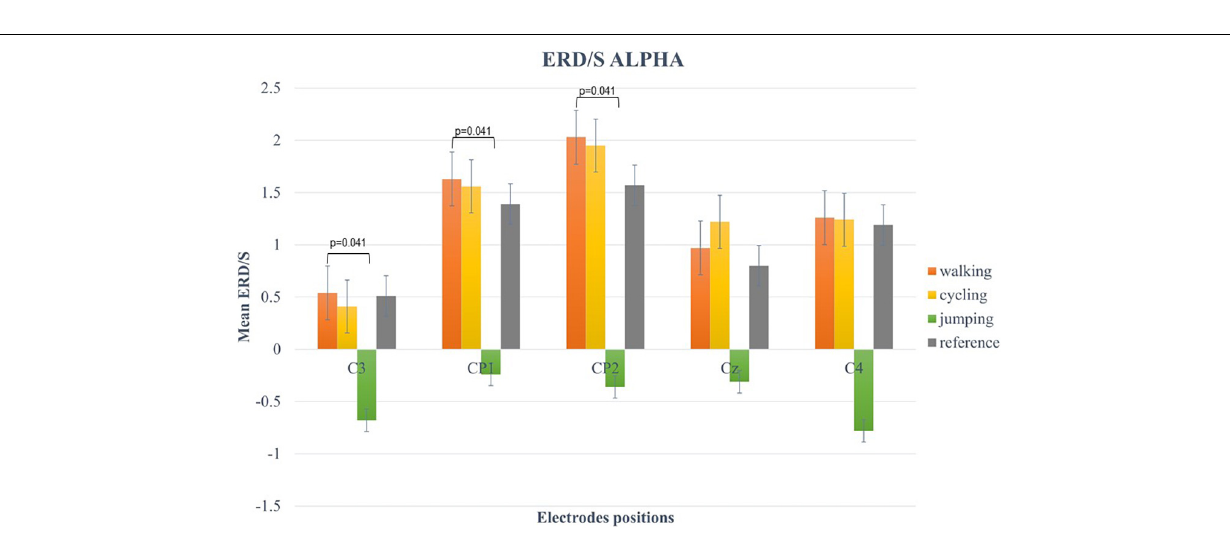
FIGURE 4 | Bar plots of mean ERD/S values of the alpha-band for all conditions at electrode positions C3, CP1, CP2, Cz, C4. Significant differences were indicated by inserting the corresponding p -value ( α < 0.05). Error bars are SE ( ±